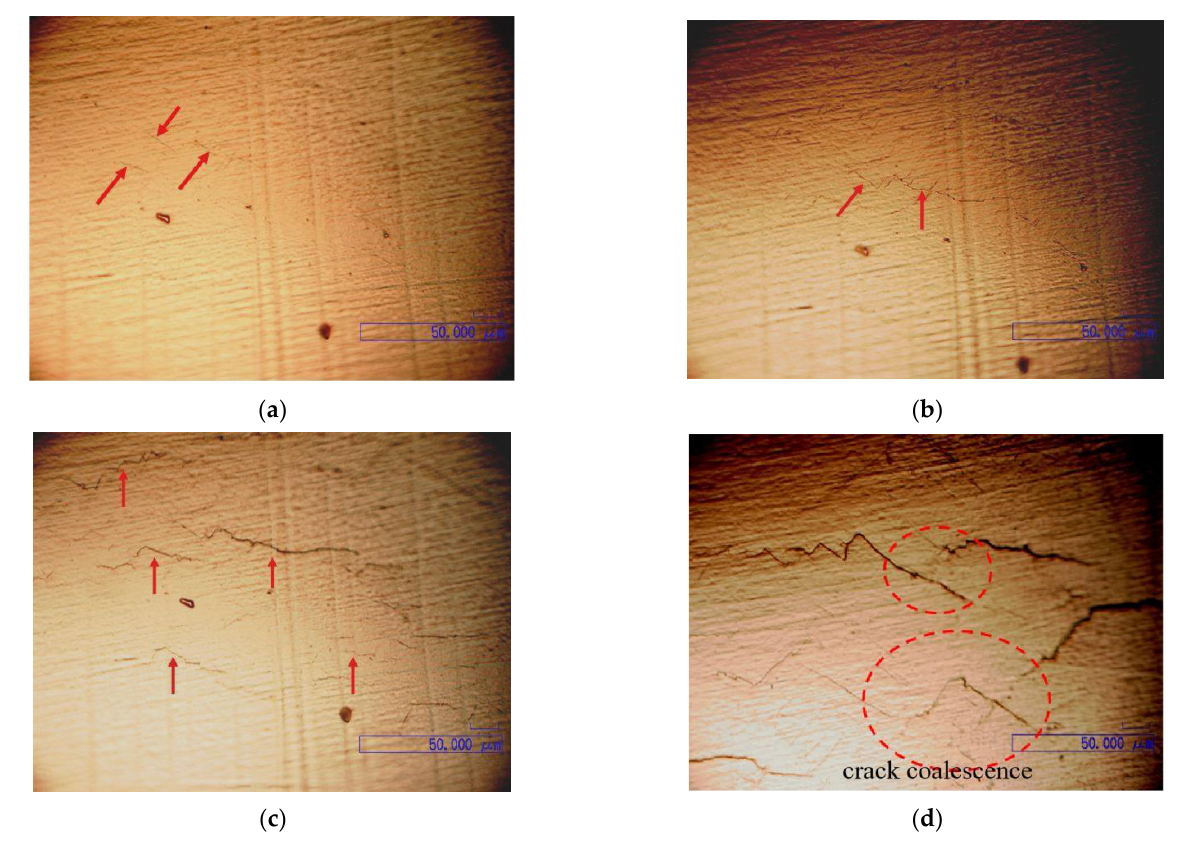
Figure 7 . Fatigue crack evolution of TC21 titanium alloy specimen under 950 MPa stress amplitude (Red arrows represent fatigue cracks; red rings represent fatigue crack coalescence). ( a ) N = 200 cycles (6% Nf ). ( b ) N = 800 cycles (23% Nf ). ( c ) N = 1400 cycles (40% Nf ). ( d ) N = 2000 cycles (57% Nf ).